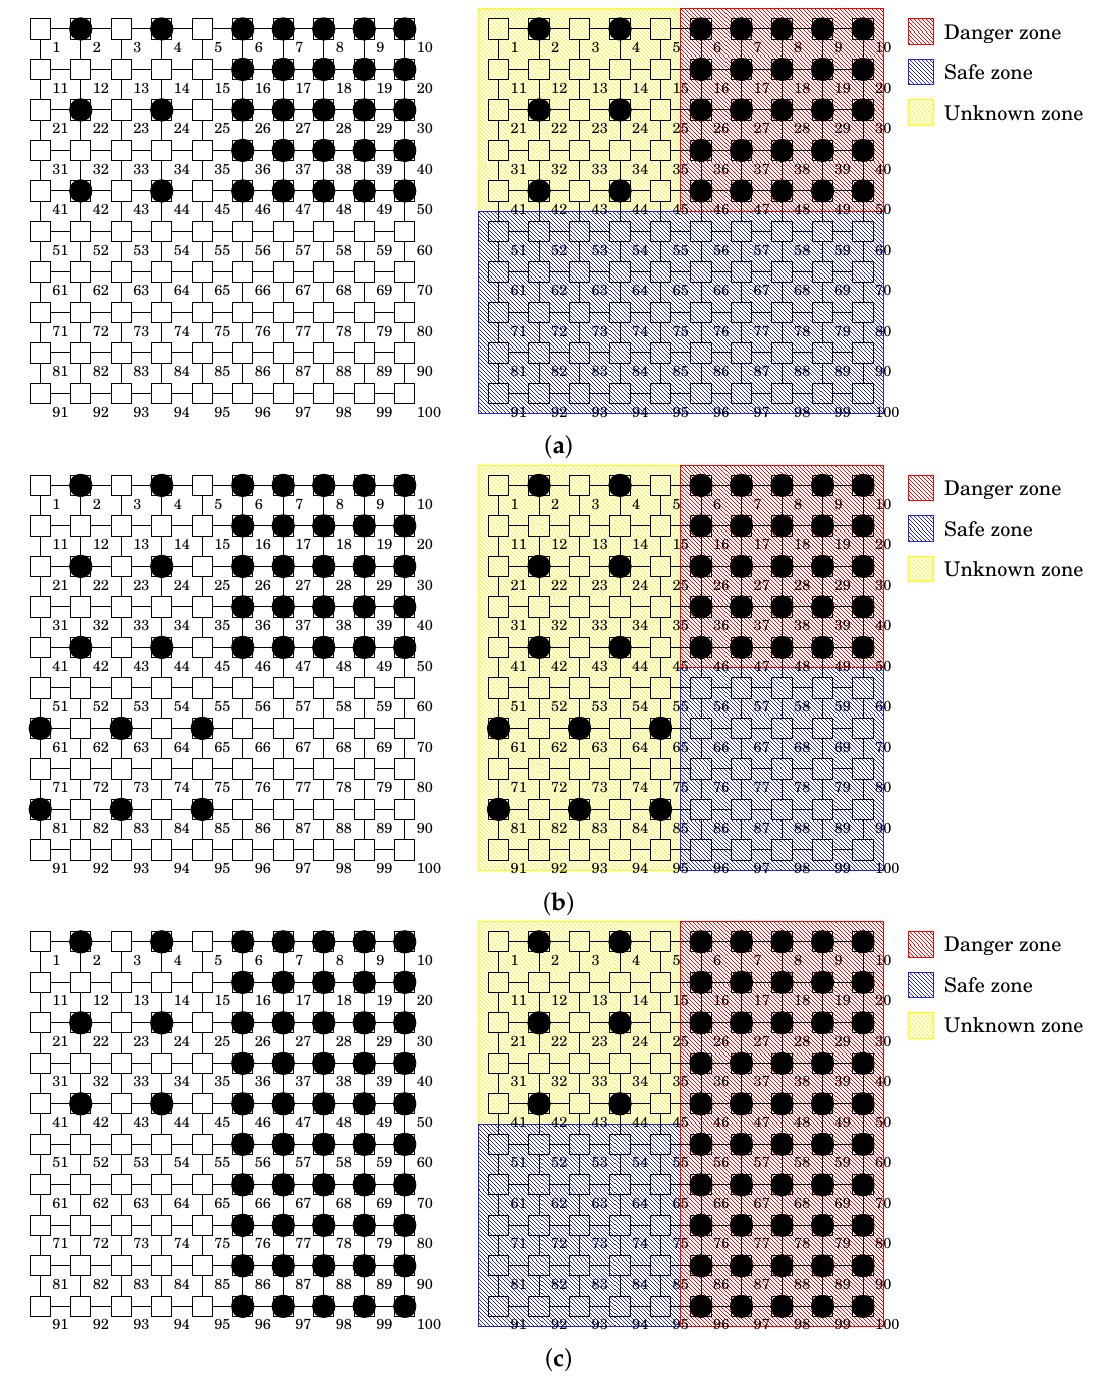
( c ) Figure 8. Three kinds of Mirai distributions in a 10 × 10 grid network used for simulation evaluation. ( a ) Distribution 1 and the result of zoning. ( b ) Distribution 2 and the result of zoning. ( c ) Distribution 3 and the result of